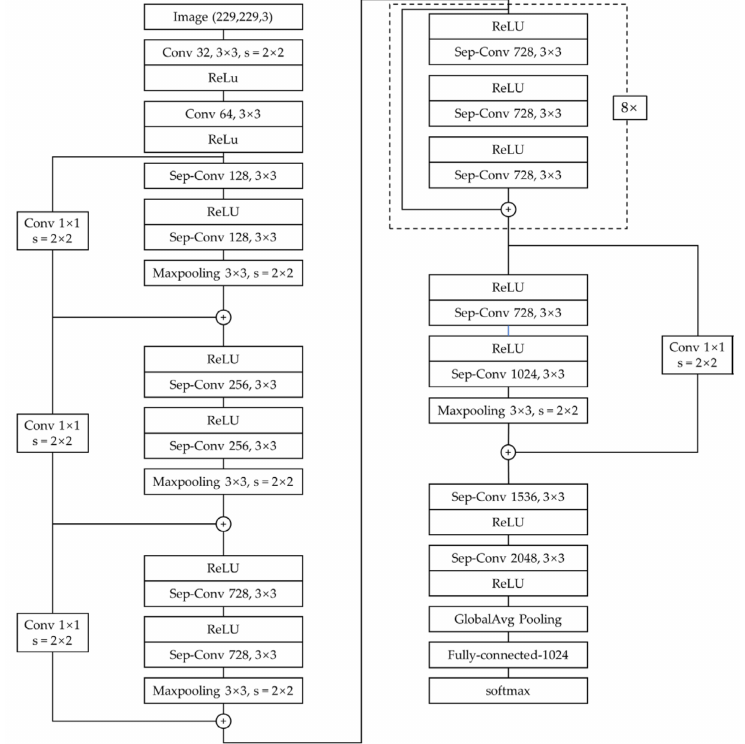
Figure 8. The Xception